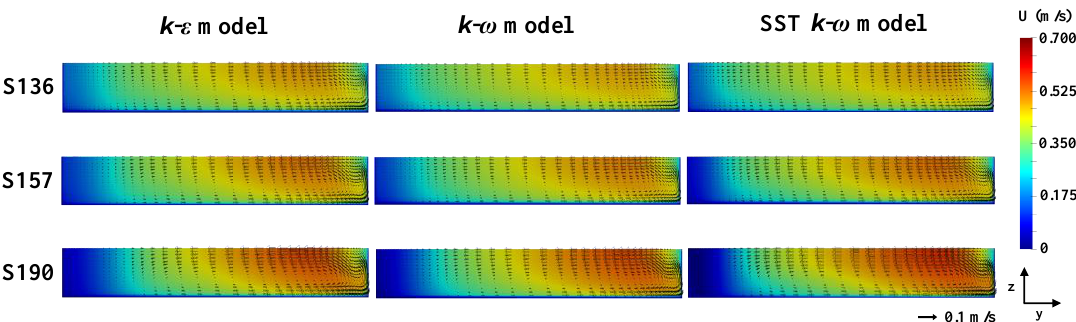
Figure 4. Cross-sectional distributions of mean velocity with secondary flows at the bend apex for simulation cases with three different turbulence models.